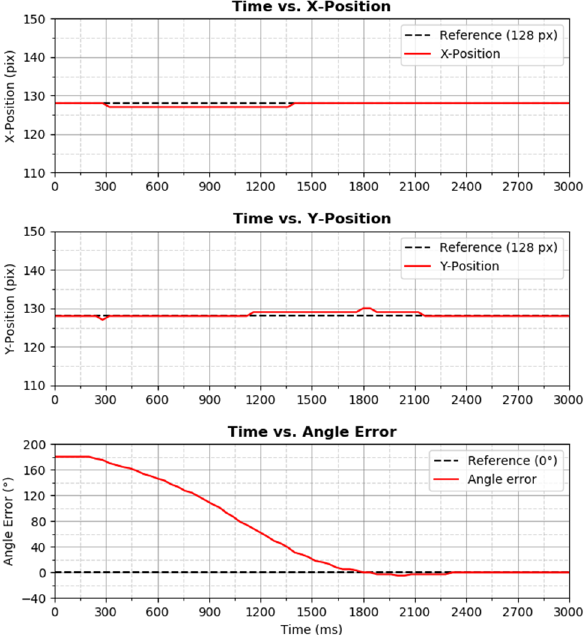
Figure 12. Orientation control by using two PD controllers at starting location (128 px, 128 px).